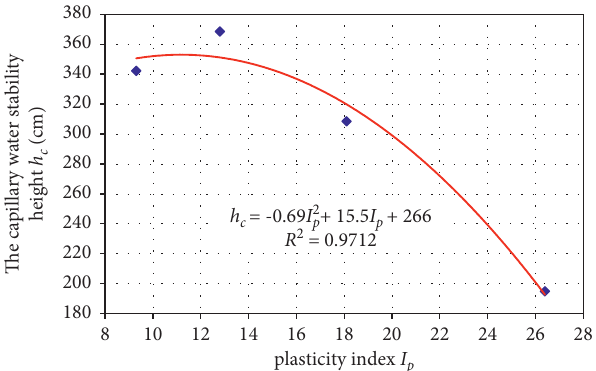
Figure 3: The rising stable height of the capillary water for the fine- grained soils as a function of I p